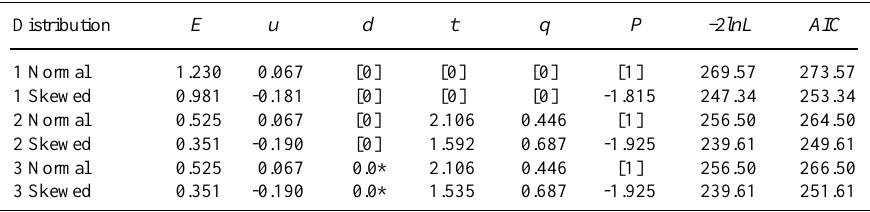
Table III - Commingling analysis of eosinophil’s levels among parasitized individuals.